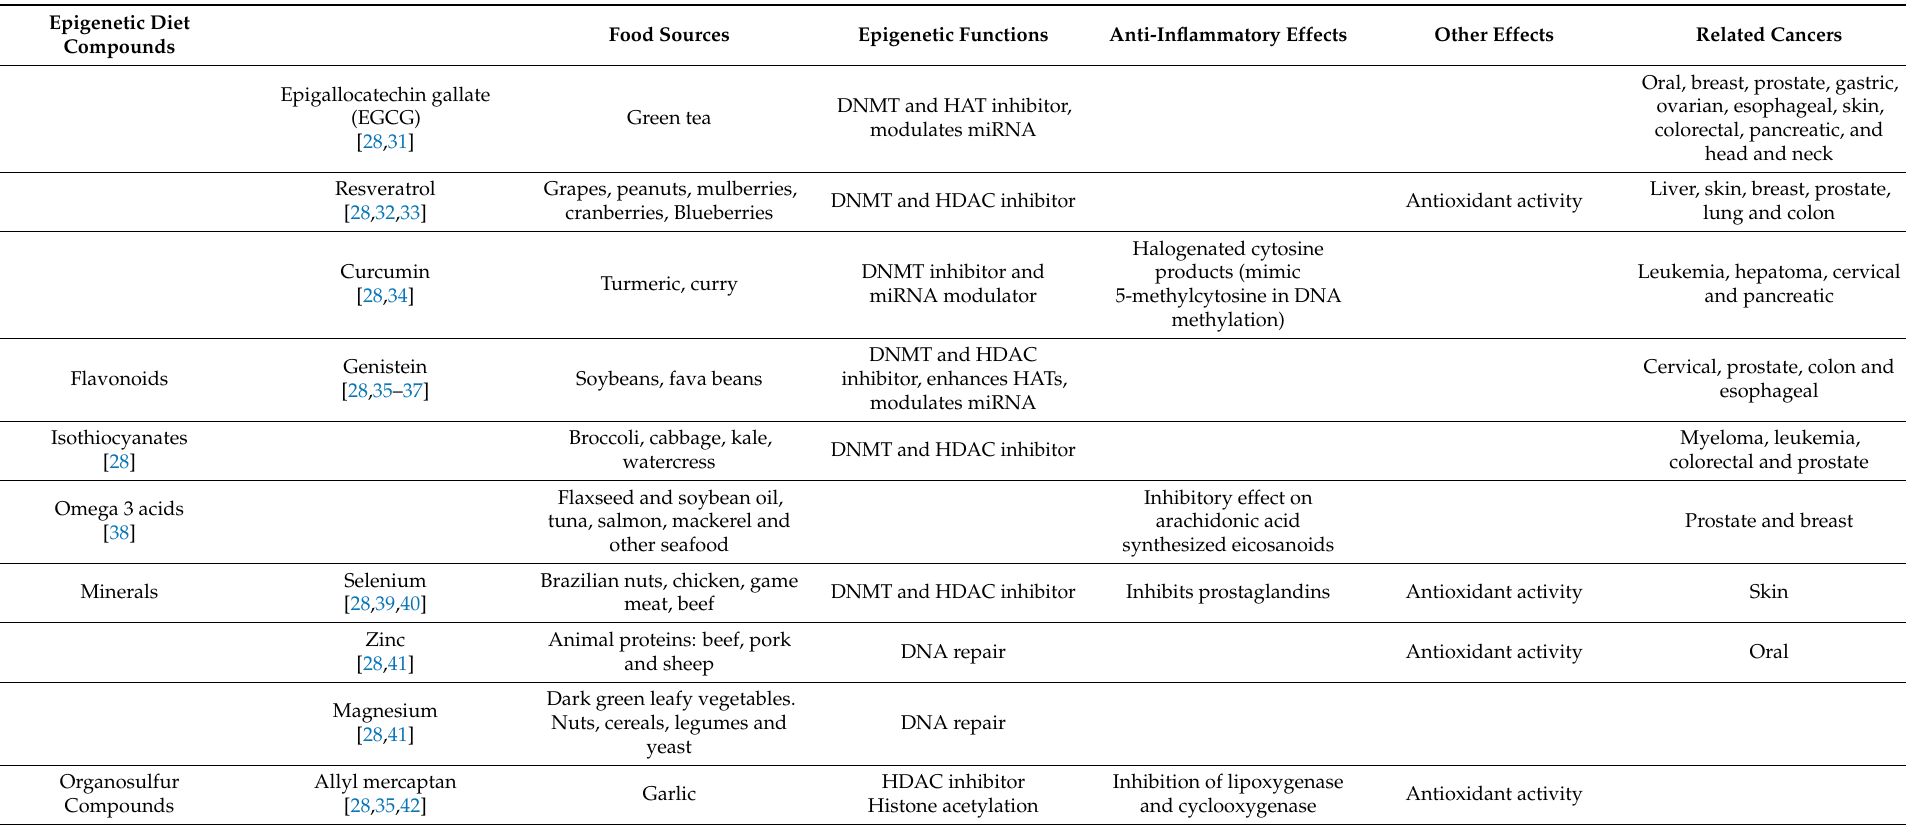
Table 1. Bioactive epigenetic diet compounds, food sources, epigenetic functions, anti-inflammatory effects and cancer types related. Modified from: Hardy, T.M.; Tollefsbol, T.O. Epigenetic Diet: Impact on the Epigenome and Cancer. Epigenomics 2011, 3, 503–518. DNMT: DNA methyltransferase; EC: Epicatechin; ECG: Epicatechin-3-gallate; EGC: Epigallocatechin;